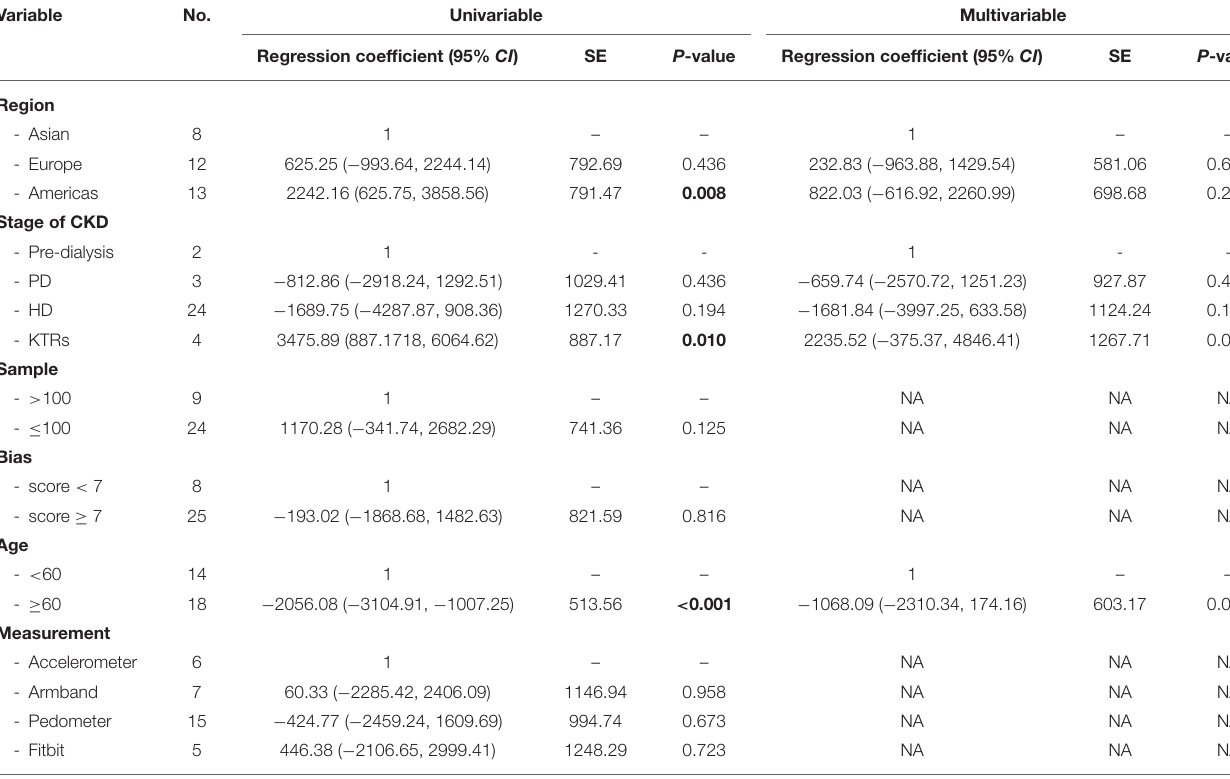
TABLE 2 | Univariable and multivariable meta-regression analysis of step count in patients with CKD. Variable